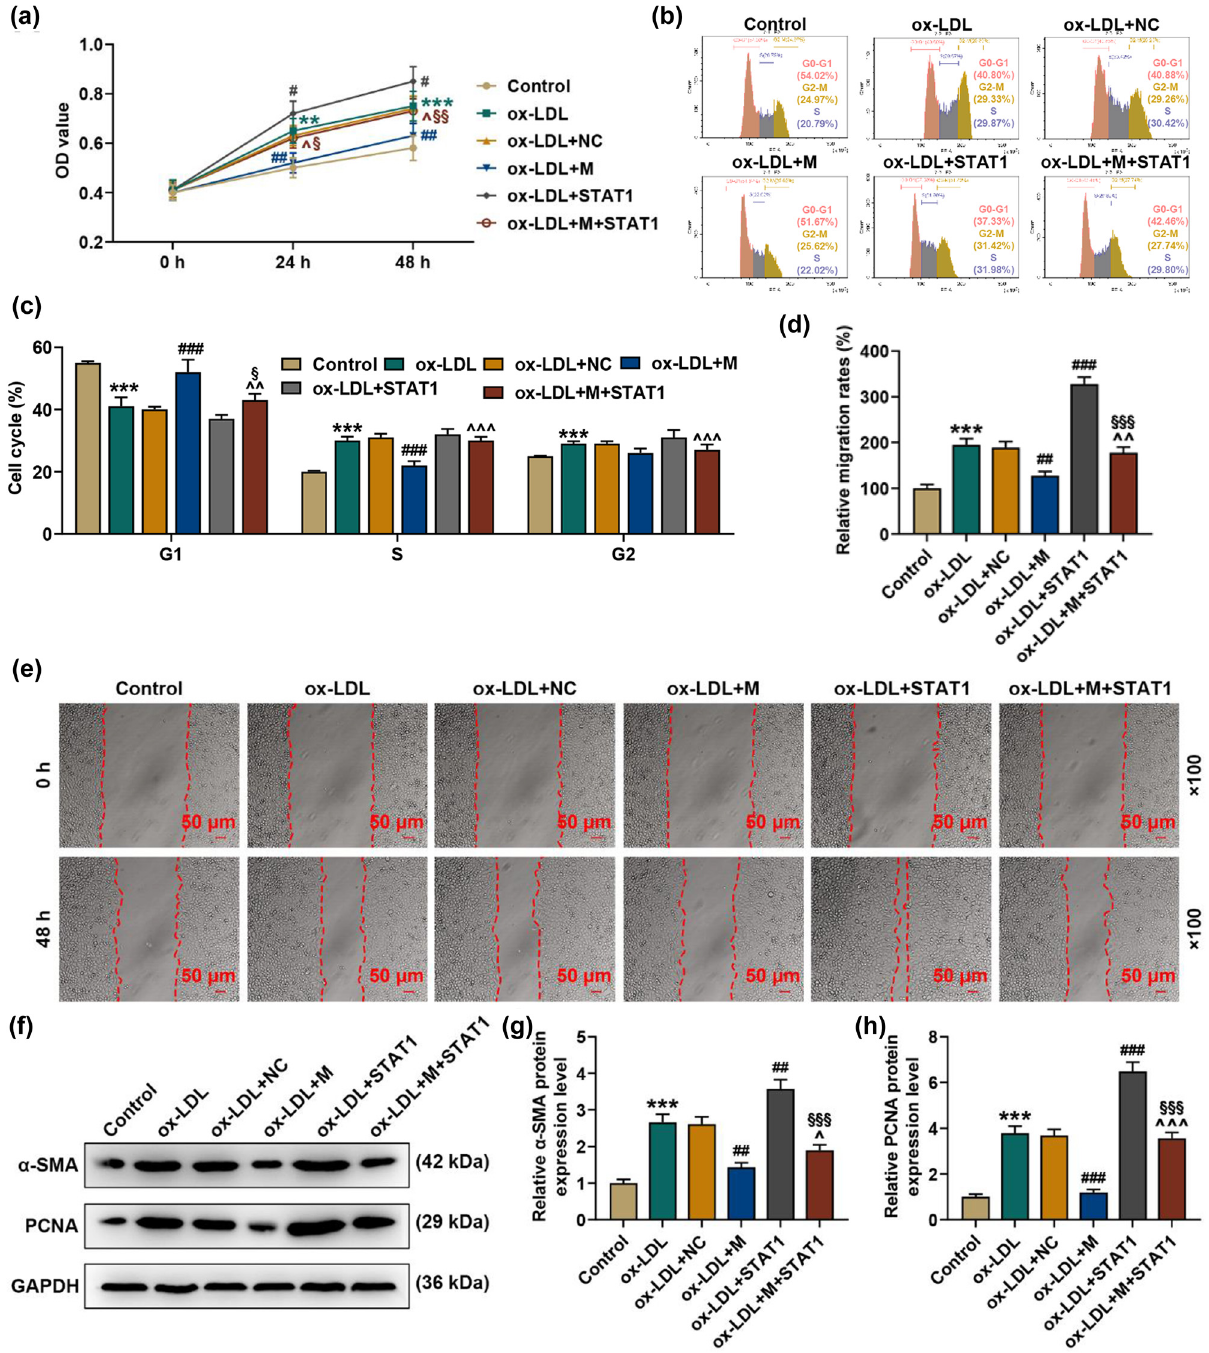
Figure 4: miR - 150 - 5p in fl uenced the viability, migration and expressions of proliferation biomarkers of ox - LDL - stimulated HASMCs via STAT1. ( a ) CCK - 8 assay was used to determine the viability of ox - LDL - stimulated HASMCs transfected with the mimic or overexpressed STAT1 at 0 h, 24 h and 48 h. ( b and c ) Flow cytometry was used to detect the cell cycle of ox - LDL - stimulated HASMCs transfected with mimic or overexpressed STAT1. ( d ) The relative migration rate normalized to the control group was calculated. ( e ) Wound healing assay was performed to assess the cell migration ability. Magni fi cation: 100 × , scale bar = 50 μ m. ( f ) – ( h ) Western blot analysis of α - SMA and PCNA in ox - LDL - stimulated HASMCs transfected with the mimic or overexpressed STAT1. GAPDH was used as the internal reference. ** p < 0.01, *** p < 0.001 vs Control; # p < 0.05, ## p < 0.01, ### p < 0.001 vs ox - LDL + NC; ^ p < 0.05, ^^ p < 0.01, ^^^ p < 0.001 vs ox - LDL + mimic; § p < 0.05, §§ p < 0.01, §§§ p < 0.001 vs ox - LDL + STAT1. All these experiments were performed three times independently. OD: optical density; M: miR - 150 - 5p mimic; NC: negative control ( empty vector ) ; ox - LDL: oxidized low - density lipoprotein; HASMCs: human aortic smooth muscle cells; α - SMA, α - smooth muscle actin ( α - SMA ) ; PCNA: proliferating cell nuclear antigen; STAT1: transducer and activator of transcription STAT